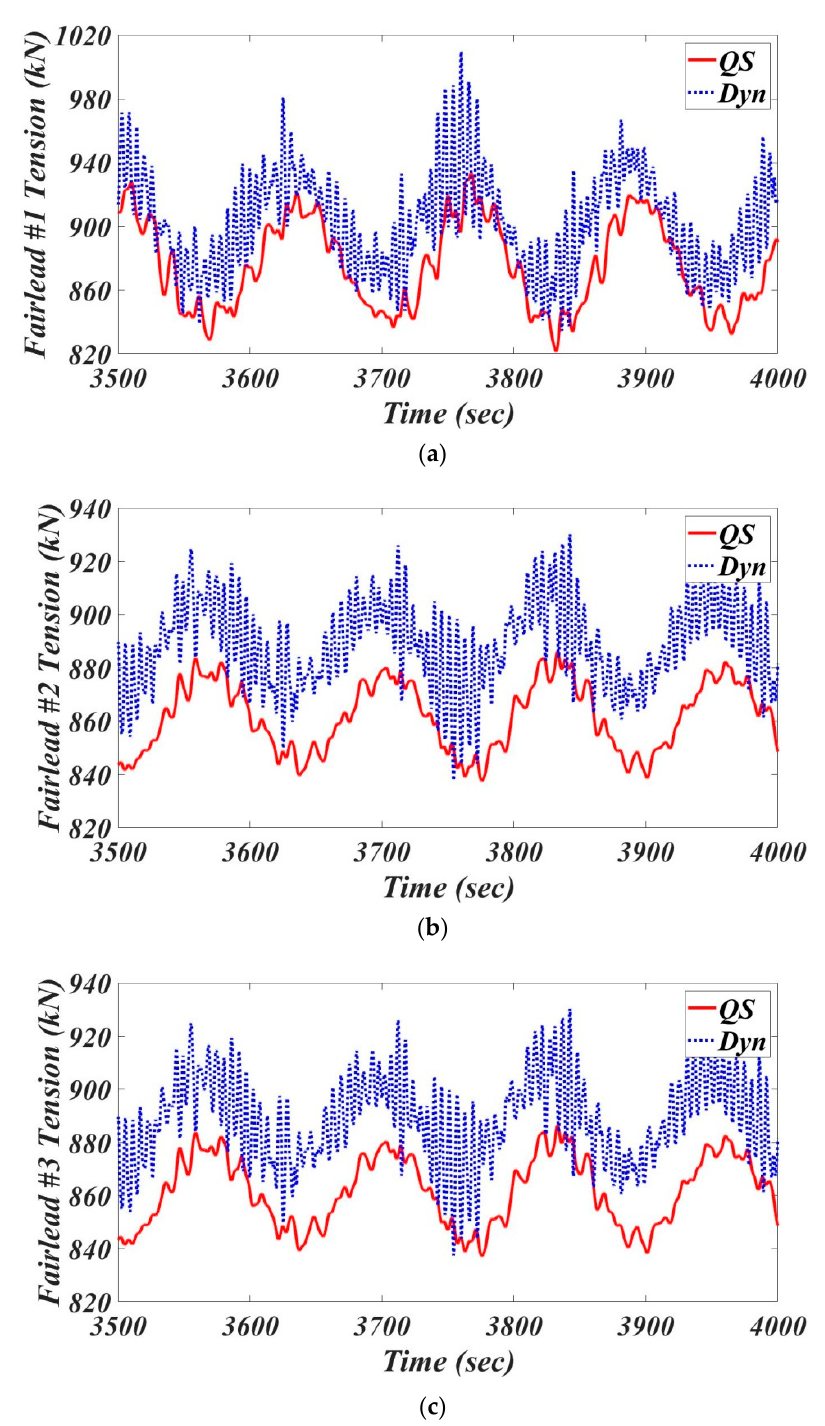
Figure 14. Time series of fairlead tension responses for the mooring cables: ( a ) #1, ( b ) #2, and ( c ) #3, respectively.